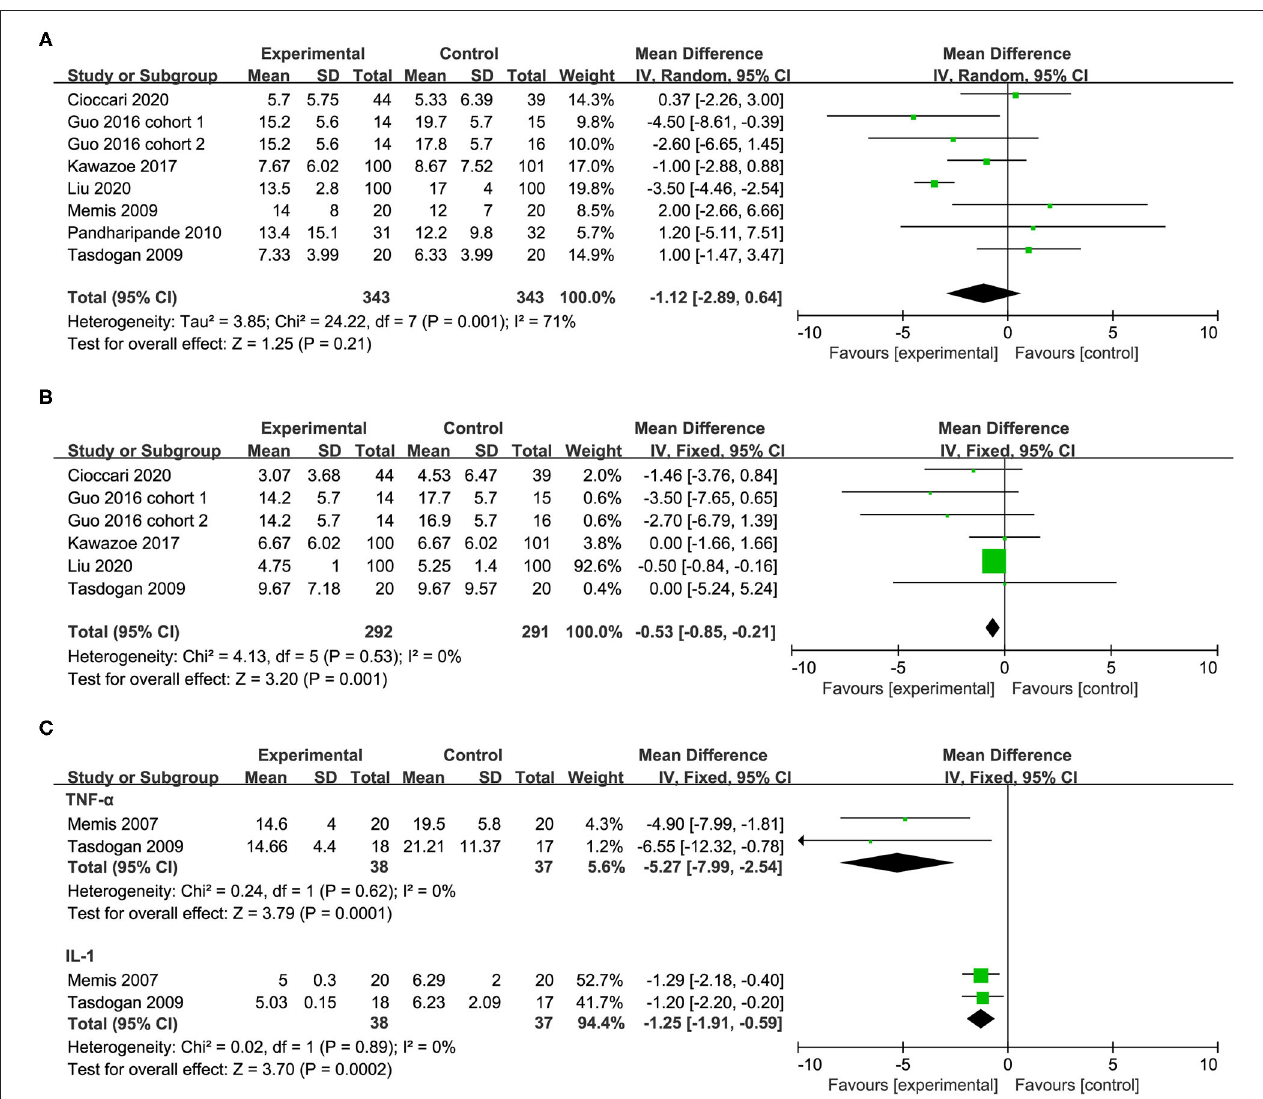
FIGURE 5 | Forest plot comparing the effect of DEX on (A) length of ICU stay, (B) duration of MV, (C) inflammatory